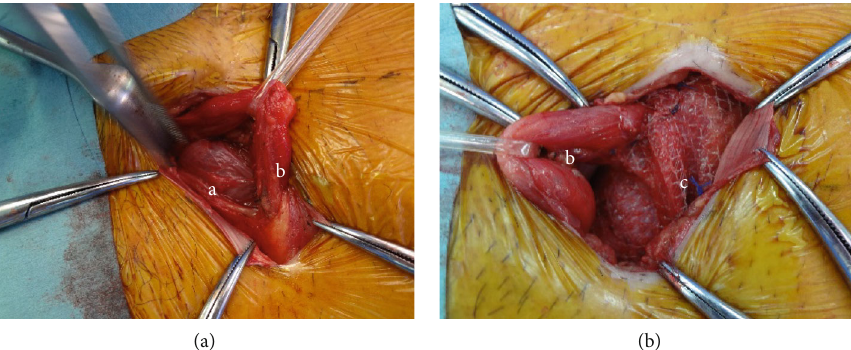
Figure 2: Intraoperative appearance of the herniated bladder in case 1. (a) Herniated bladder. (b) Spermatic cord. (c) Polypropylene mesh.